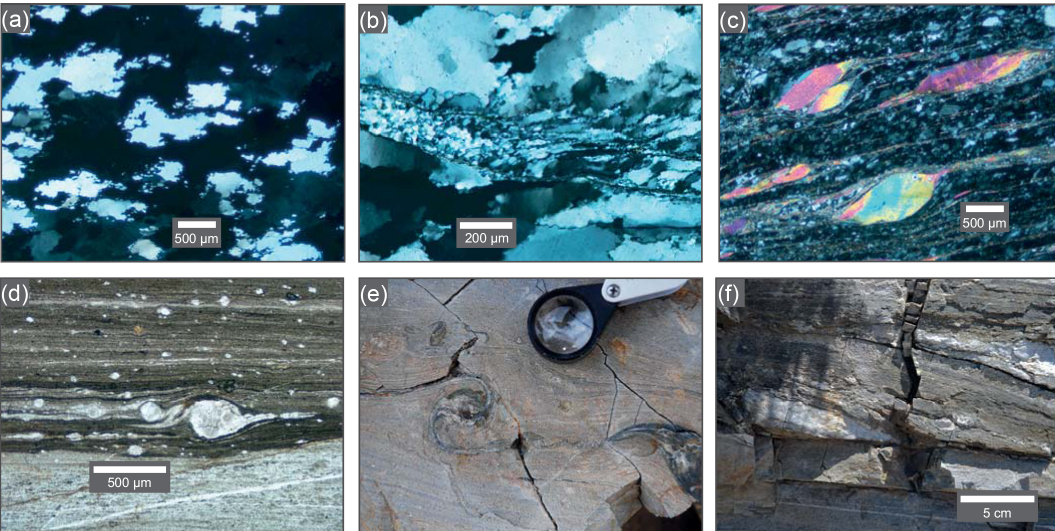
Figure 7. Field and thin section photographs from the Ruby Mountains–East Humboldt Range. Locations are shown in Fig. 2c and listed in Table 1. All images are oriented with WNW to the right. (a) Quartzite from Angel Lake exhibiting a composite microstructure of millimeter- sized quartz grains with a high-temperature, sub-LDT microstructure and approximately 5% dynamic recrystallization by subgrain rotation to a grain size of ∼ 20µm. (b) The high-temperature fabric is overprinted by a high-stress, probably detachment-related, shear band defined by dynamic recrystallization through bulge nucleation with a grain size of ∼ 5µm. This is analogous to the northern Snake Range sample in Fig. 6d. (c) Mylonitic gneiss from below the lower detachment at Secret Pass exhibiting a composite microstructure with Regime 2 dynamic recrystallization at the 100µm level followed by a weak high-stress overprint. Mica fish highlight the top-WNW sense of shear. (d) Mylonite gneiss from beneath the main detachment at Secret Pass. The matrix shows full dynamic recrystallization of quartz to ∼ 10µm, and extensive fine-grained dynamic recrystallization in tails around feldspar delta-type porphyroclasts. (e) Ultramylonite beneath the main detachment at Secret Pass with winged inclusions (Grasemann and Dabrowski, 2015). Similar features are found close to the detachment in the northern Snake Range (Fig. 6e). Panels (d) and (e) were previously published in Platt et al. (2015). (f) Field photo of a small-scale brittle shear cutting mylonitic gneiss at Secret Pass. The brittle slip surfaces follow the foliation, suggesting that deformation occurred close to the BDT. This is comparable to similar observations in the Whipple Mountains (Fig.